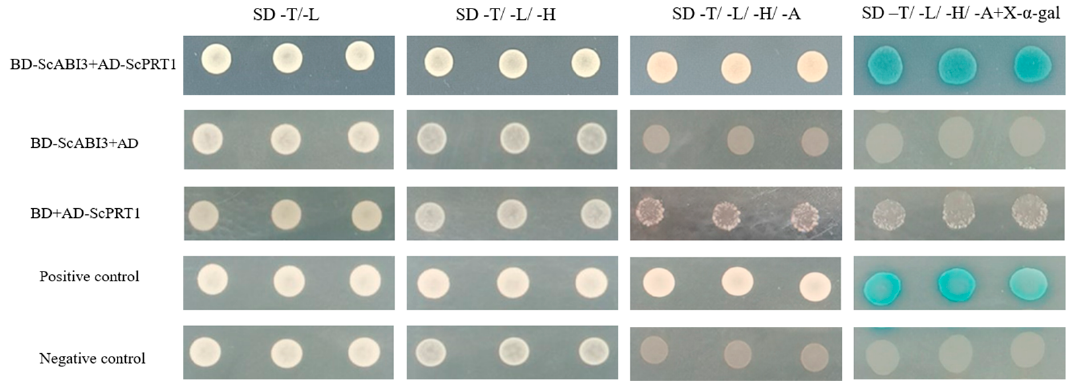
Figure 3. Interaction test by Y2H assay. The transformed cells were plated onto SD-T: -trp, SD-L: - leu; SD-TL: -trp, -leu; SD-TLH: -trp, -leu, -his; SD-TLHA: -trp, -leu, -his, -ade medium. The